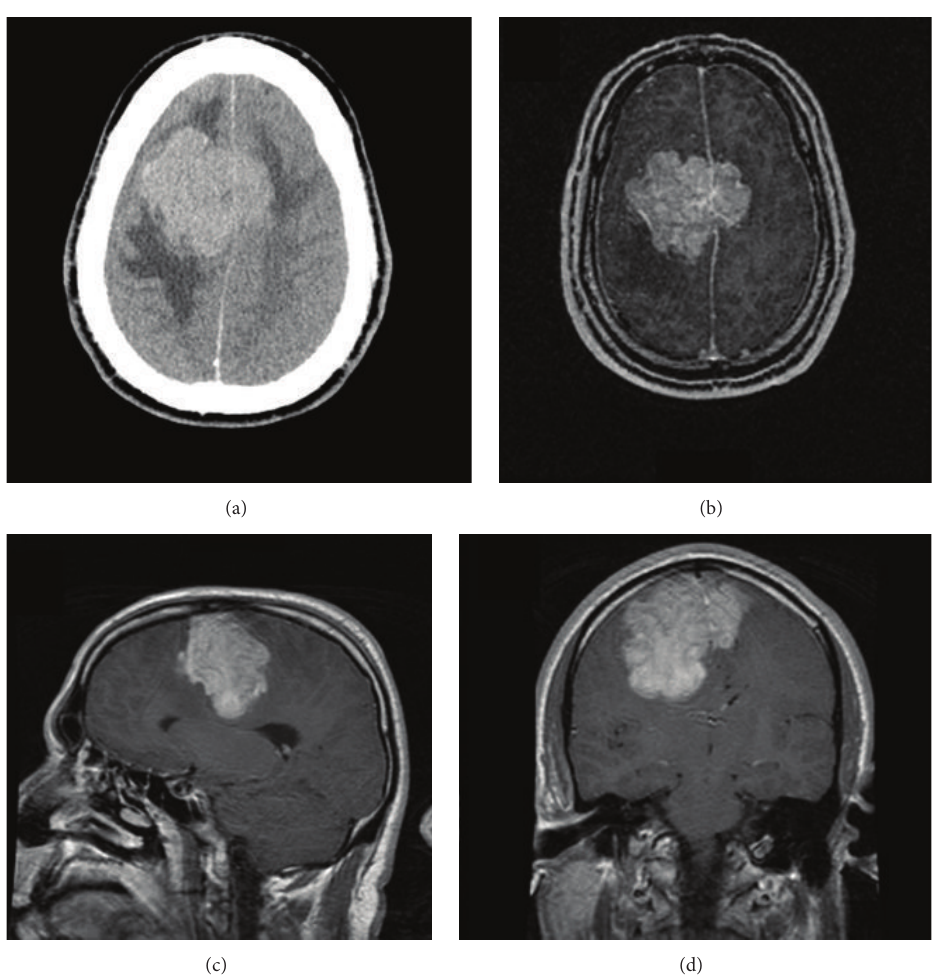
Figure 1: Axial, noncontrast CT scan (a) demonstrating a hyperdense, bifrontal, parasagittal lesion with surrounding vasogenic edema. T1 weighted, postcontrast MRI images showing (b) axial, (c) sagittal, and (d) coronal views of the